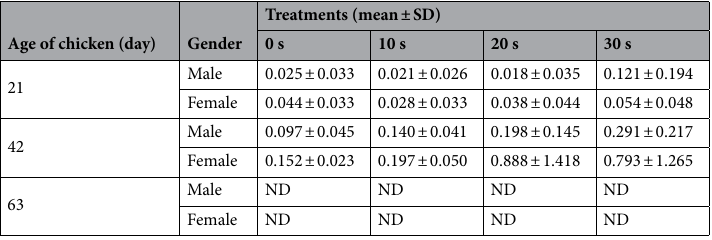
Table 4. Comparison serum growth hormone level (Mean ± SD) among 4 treatments. Not detected. (ND) when the result was less than 0.03 ng/ml.